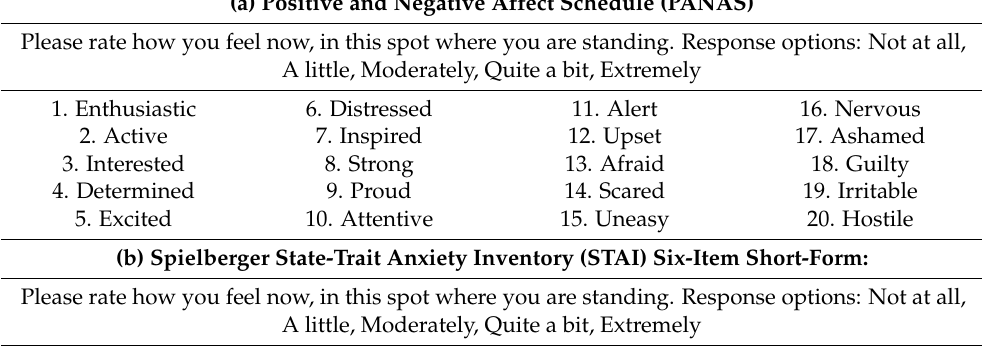
Table 1. Mental health scales used in a short face-to-face questionnaire: ( a ) Positive and Negative Affect Schedule (PANAS), containing 10 positive and 10 negative words, and ( b ) State-Trait Anxiety Inventory (STAI) six-item short-form, containing six words that relate to